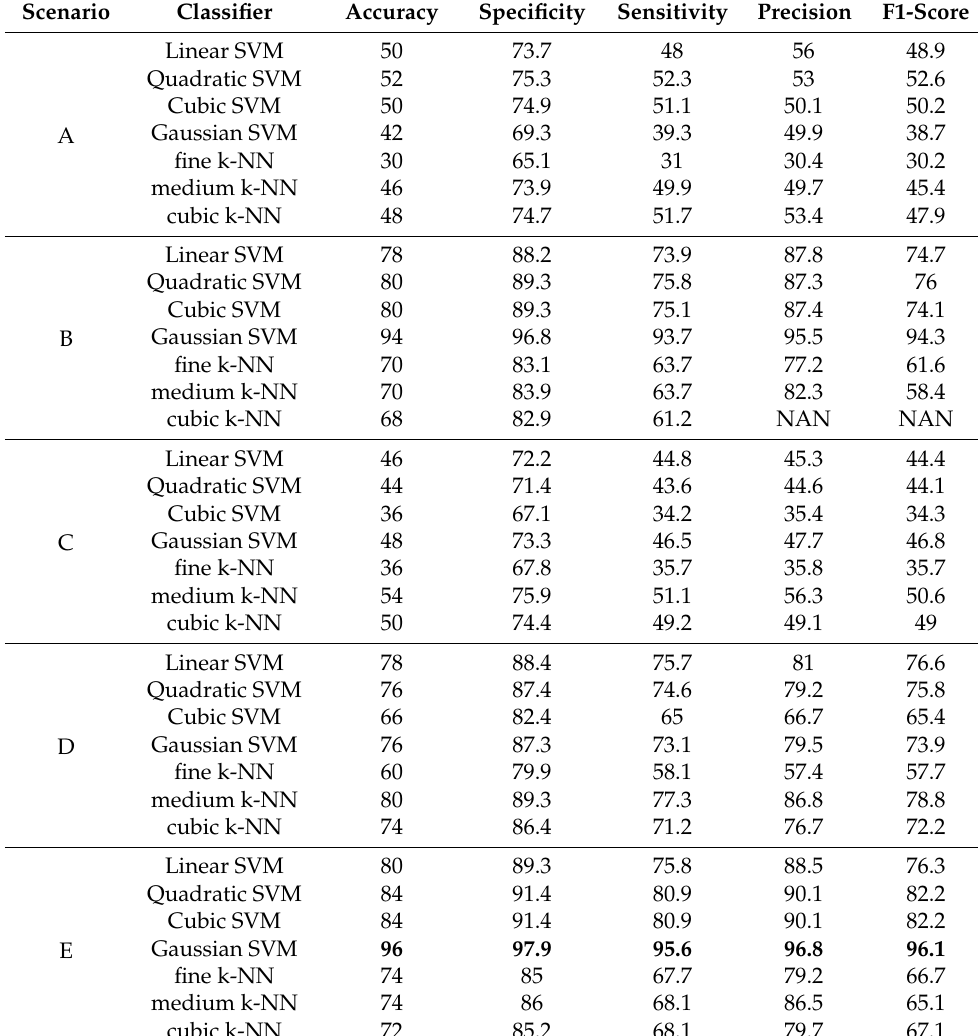
Table 12. Classification results for each scenario.